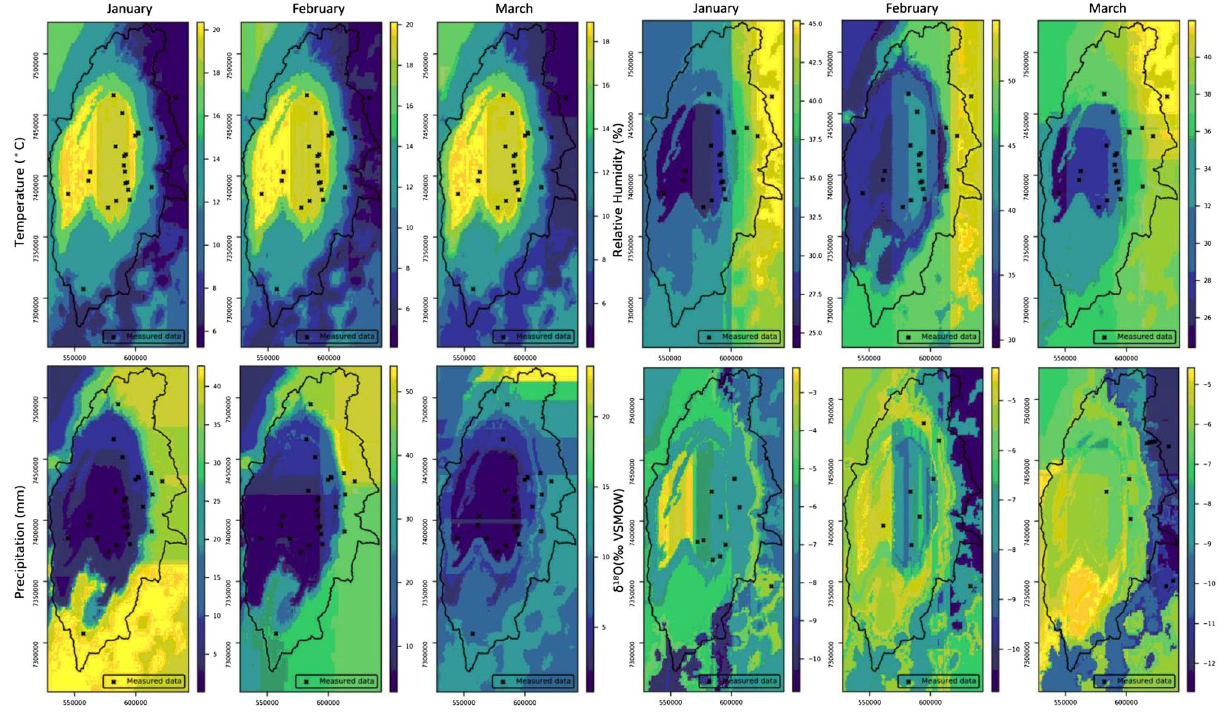
Figure 14. Maps of the temperature, precipitation, relative humidity and δ 18 O values of precipitation estimated by Isocompy in January, February and March in the Salar de Atacama basin.